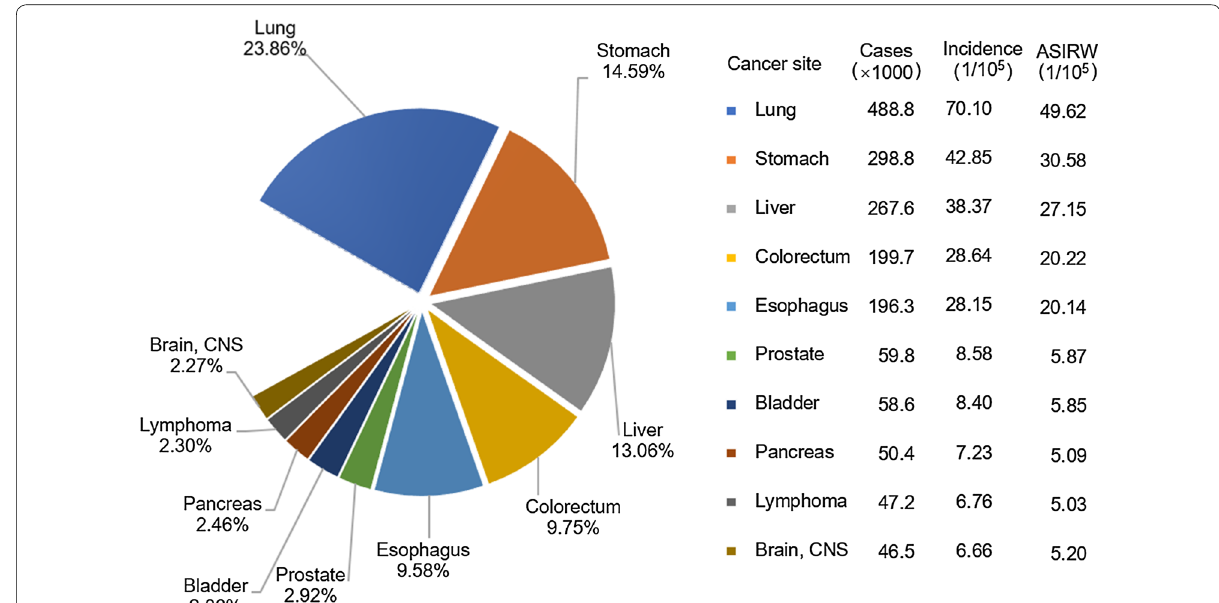
Fig. 1 Incidences of top 10 cancers for males in China, 2013. ASIRW age-standardized incidence rate adjusted by the world Segi’s population, CNS the central nervous system